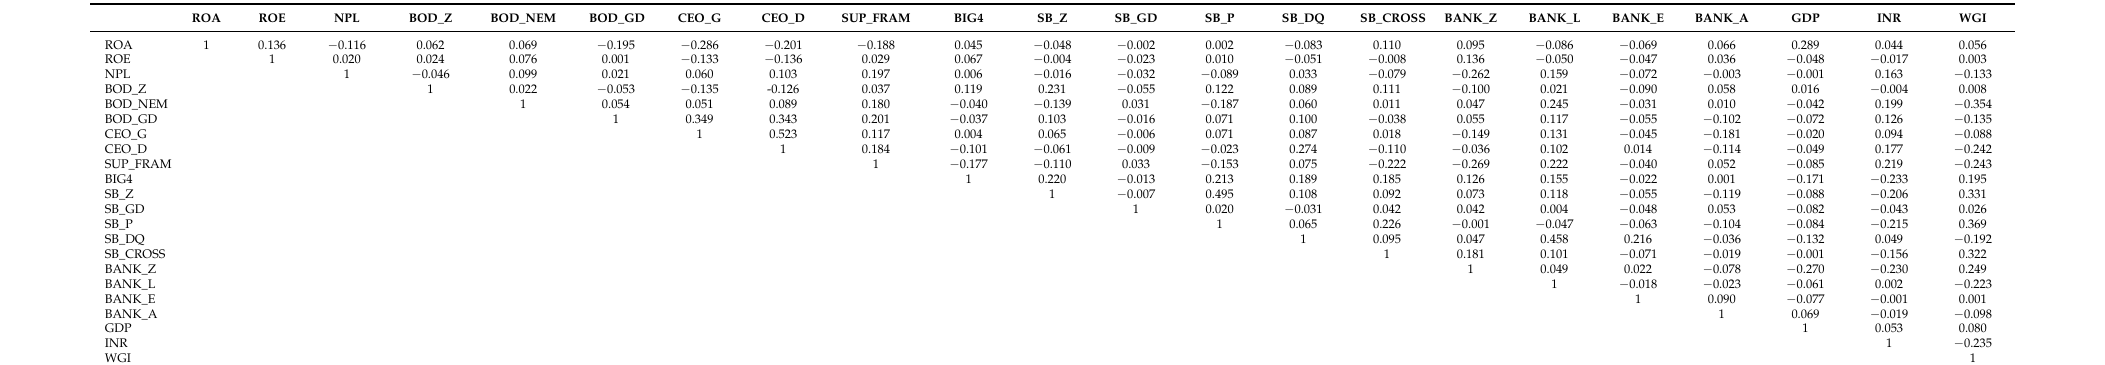
Table A2. Correlation matrix—Islamic